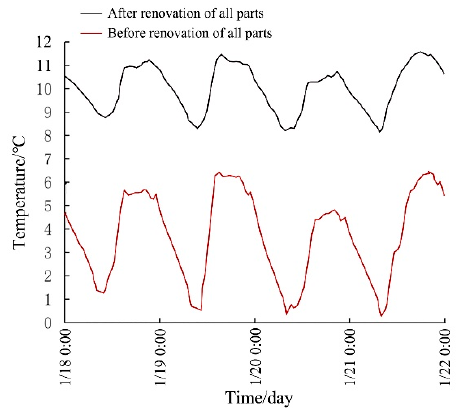
Figure 22. The simulated temperature of the master bedroom before and after renovation of all